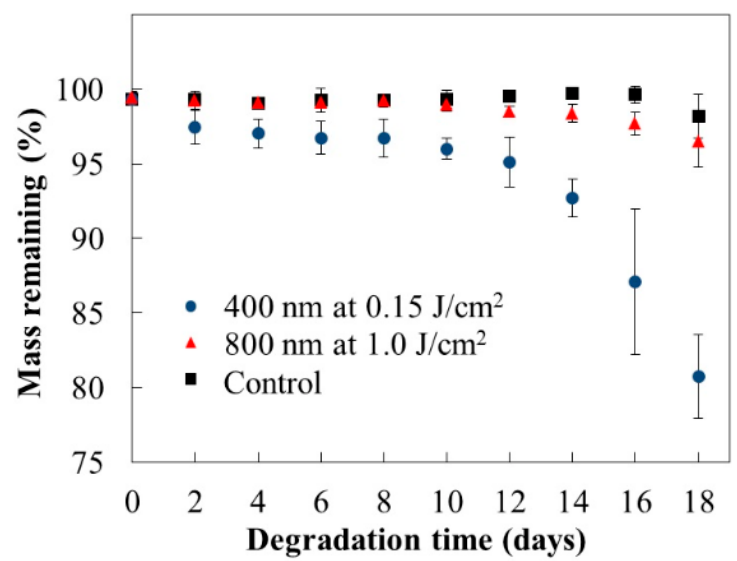
Figure 4. Mass of PLGA films remaining during degradation. Closed squares, red triangles, and closed blue circles indicate PLGA films without laser irradiation, PLGA films irradiated at 800 nm, and PLGA films irradiated at 400 nm, respectively.